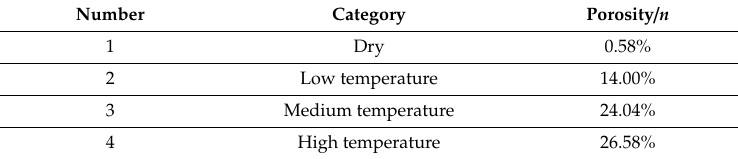
Table 2. Statistical table of the porosity change in red-bed sandstone in the different temperature flows.